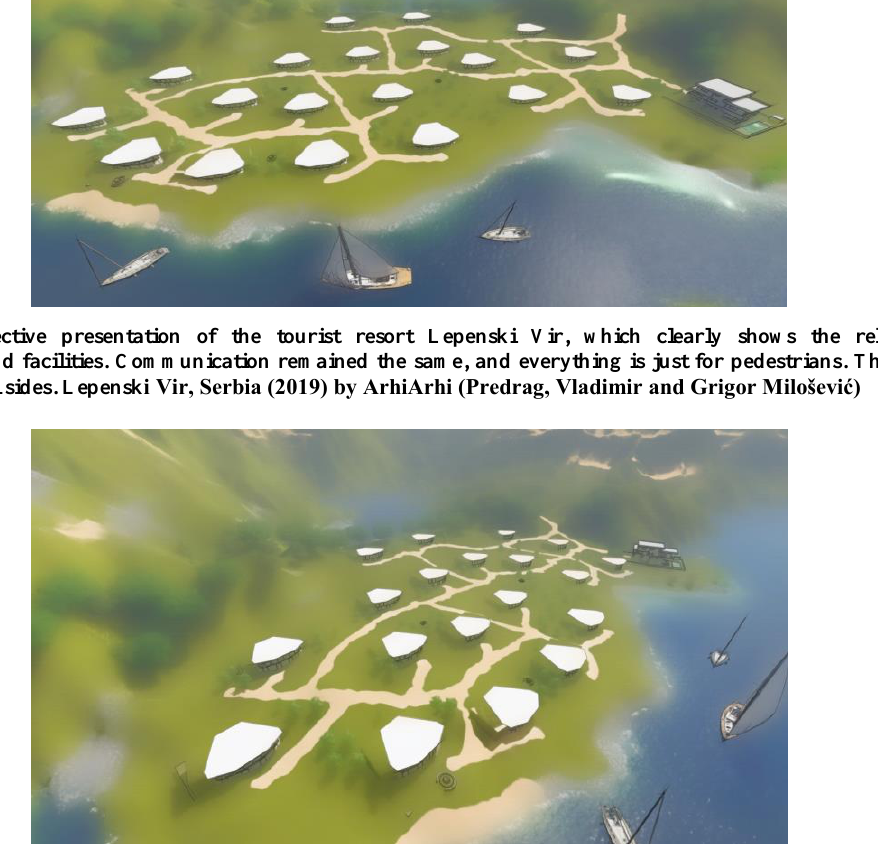
Figure 31. In the right-hand corner of the perspective view, the object can be noticed by a different appearance than others. It is a reception building, where people meet and socialize, where medical help is also located. Our inheritance can be added only to what is necessary, without today it cannot exist. We should not give up on tradition simply because what it offers is not practical at first hand. Lepenski Vir, Serbia (2019) by ArhiArhi (Predrag, Vladimir and Grigor Milošević)